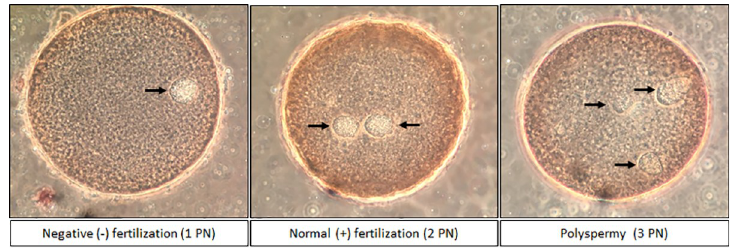
Fig 1. Pronuclear (PN) assessment and determination of fertilization via Lacmoid staining to evaluate the in vitro fertilization rate (arrows indicate the pronuclei).